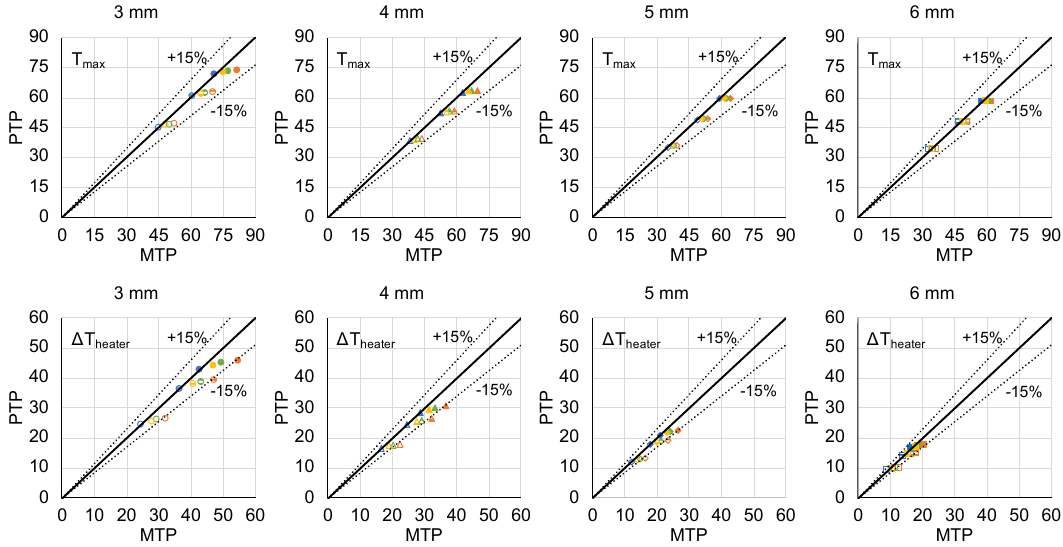
Figure 5. T max and Δ T heater values at different pipe diameters for MTP and PTP, and MTP and PTP comparison with ±15 deviation bands.